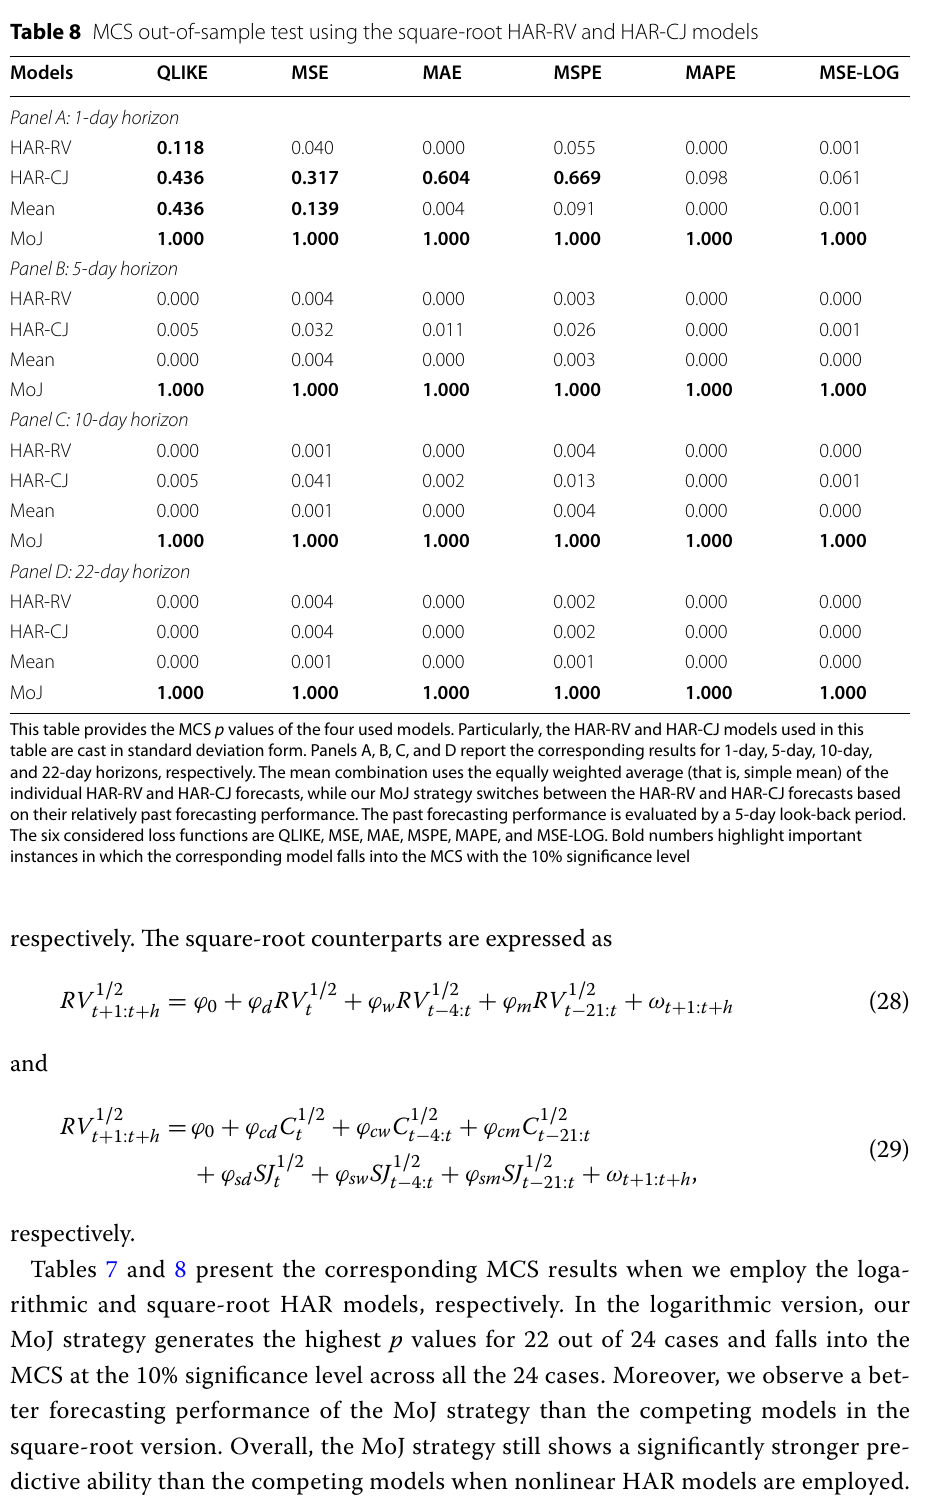
Table 8 MCS out-of-sample test using the square-root HAR-RV and HAR-CJ models